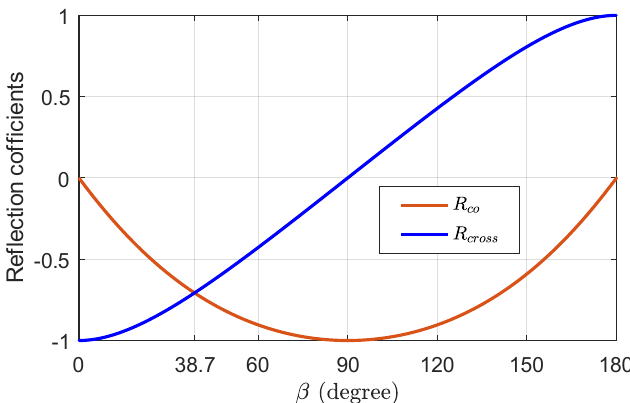
Figure 5. Components of the reflection dyadic of an infinite SHDB plane with T d = T s = 1 for a plane wave incident at θ i = 45 ◦ as functions of β